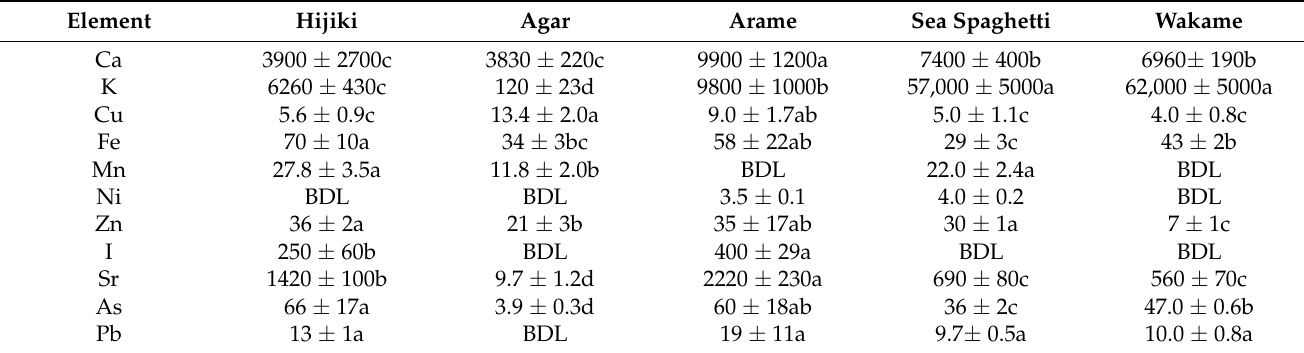
Table 2. Elemental composition of different multicellular algae.